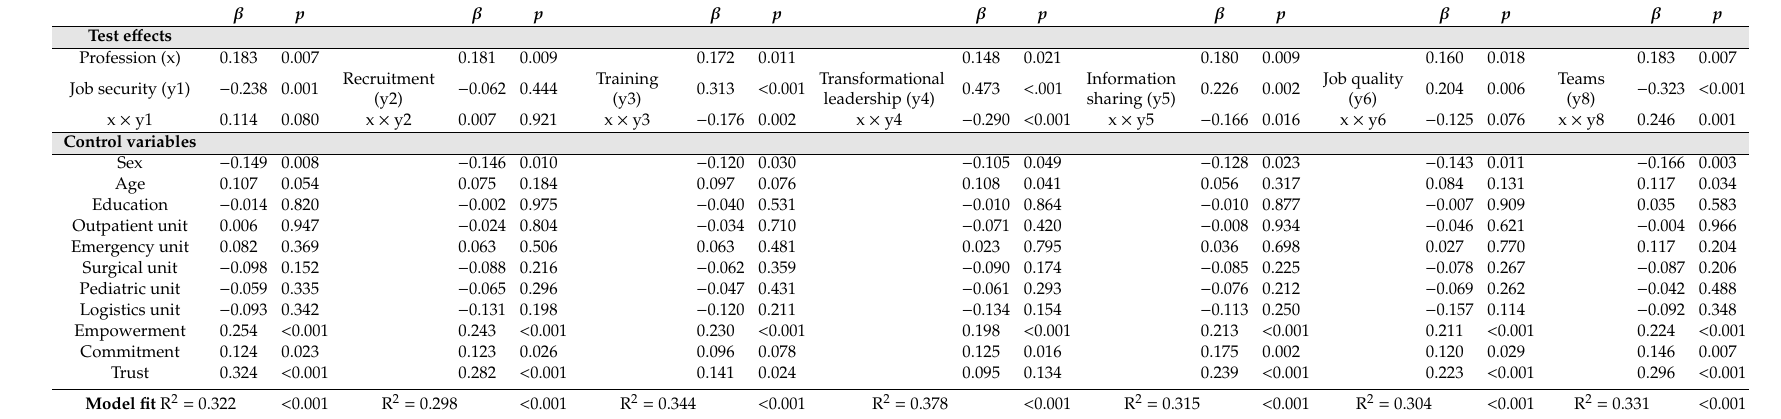
Table 4. E ff ects of profession and management practice on ratings of patient care